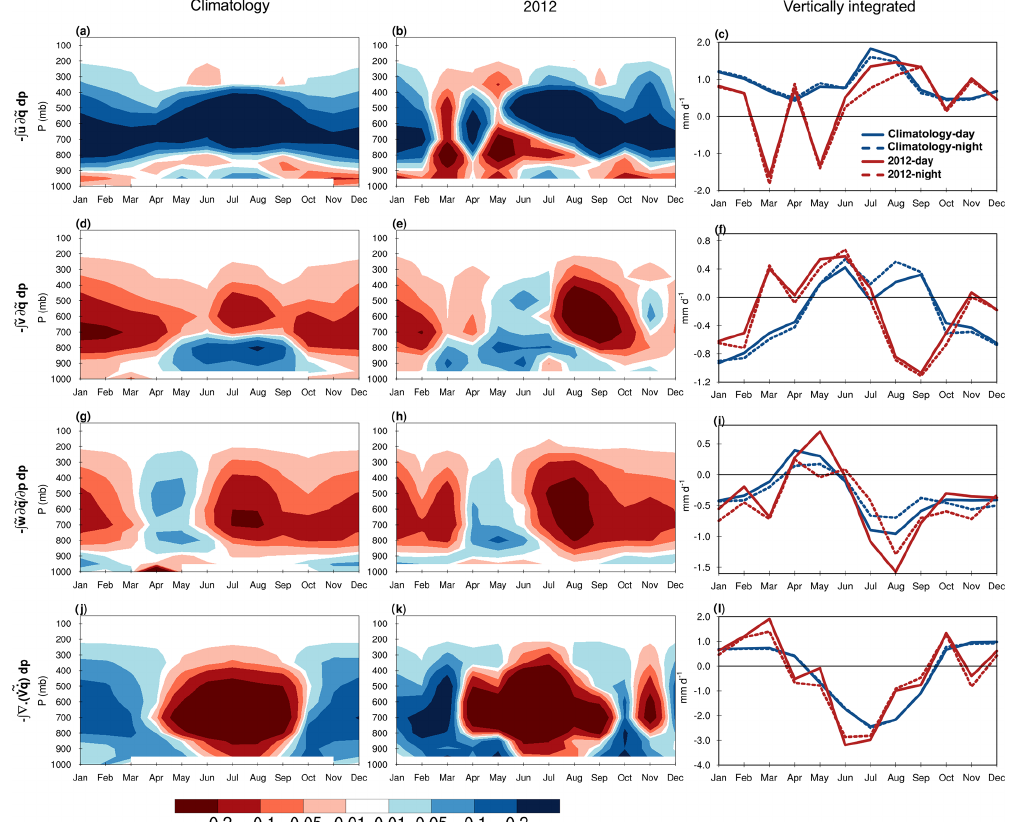
Figure 7. Same as Fig. 6 but for the NGP in